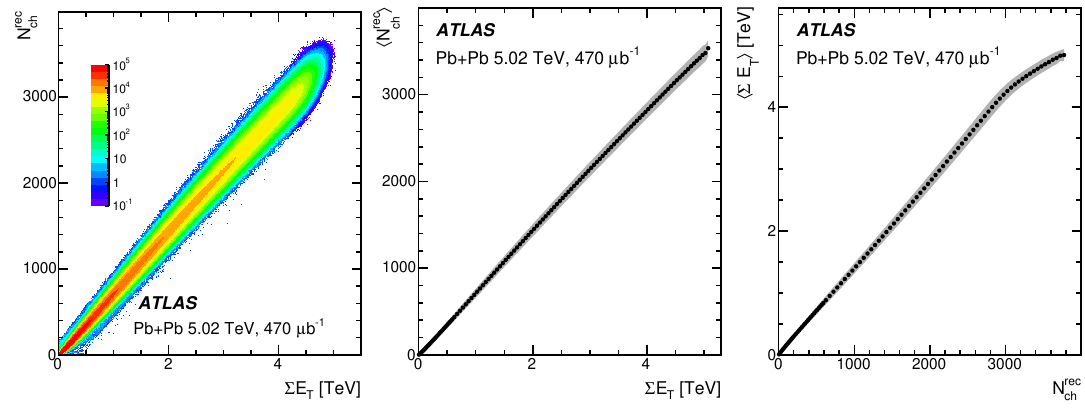
Figure 1 . The correlation between N rec root-mean-square (shaded bands) of either the N rec (middle panel) or the (cid:6) E T distributions for events in narrow slices of N rec